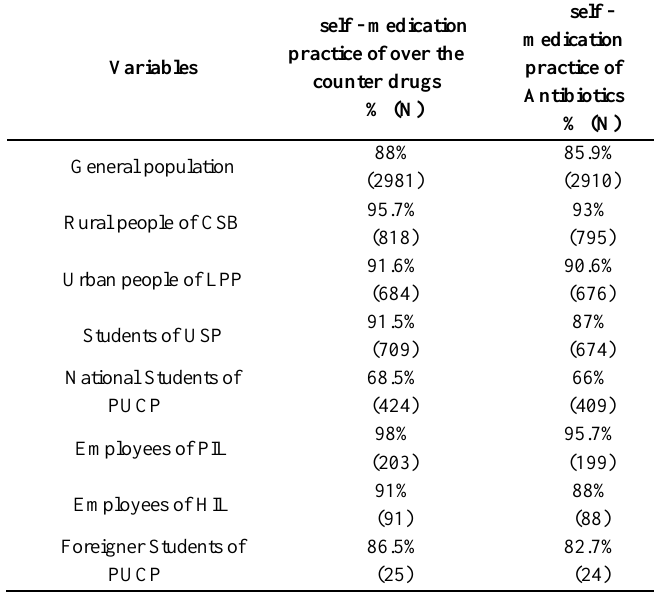
Table 1: Self-medication practice among general population as